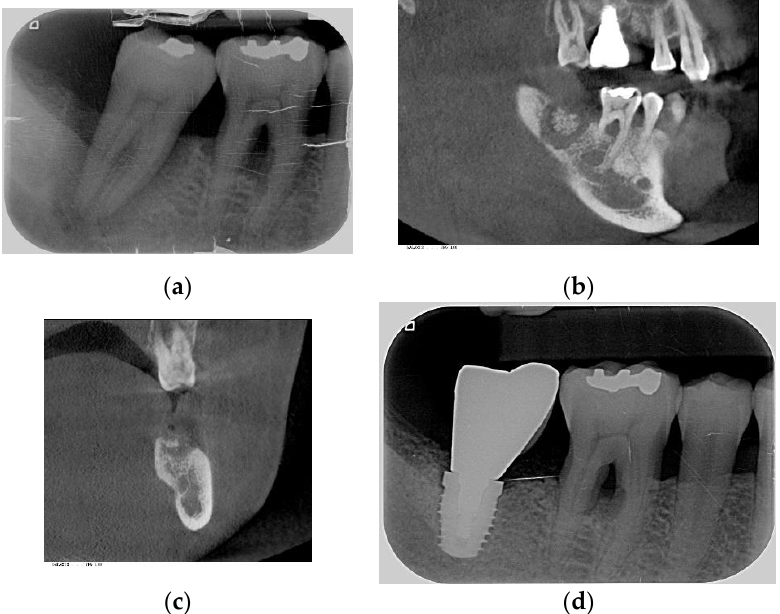
Figure 1. Implant site development of 62-year-old male patient using bovine bone and porcine collagen plug: ( a ) periodontitis-induced severe bone destruction on right-mandible second molar; ( b ) result three months after flapless ridge preservation shown in cone beam computed tomography (CBCT; sagittal view); ( c ) CBCT (frontal views); and ( d ) follow-up after prosthetic completion.